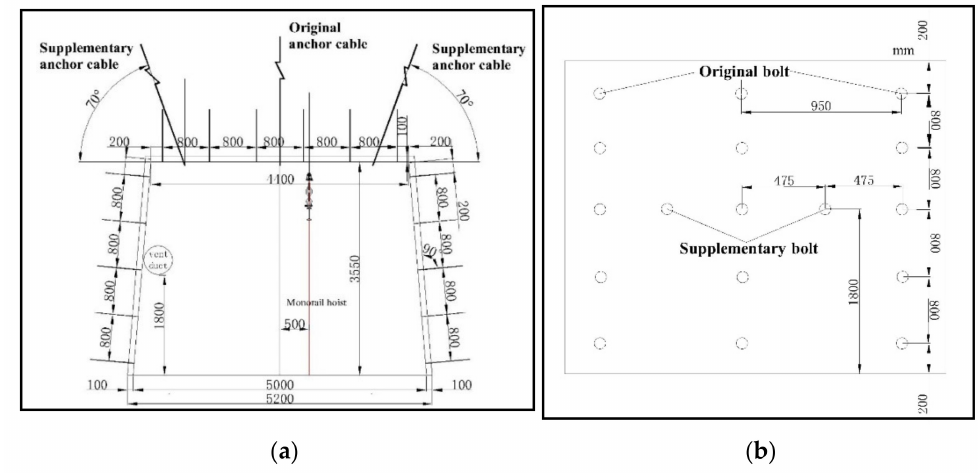
Figure 14. Schematic diagram of reinforcement and support for the gob-side roadway: ( a ) roadway reinforcement support section; ( b ) diagram of the reinforcement scheme for the two ribs of the